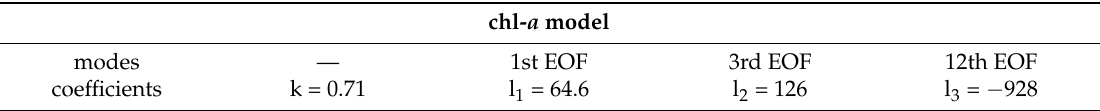
Table 4. Selected empirical orthogonal function (EOF) modes and regression coefficients (4) of the chl- a model.